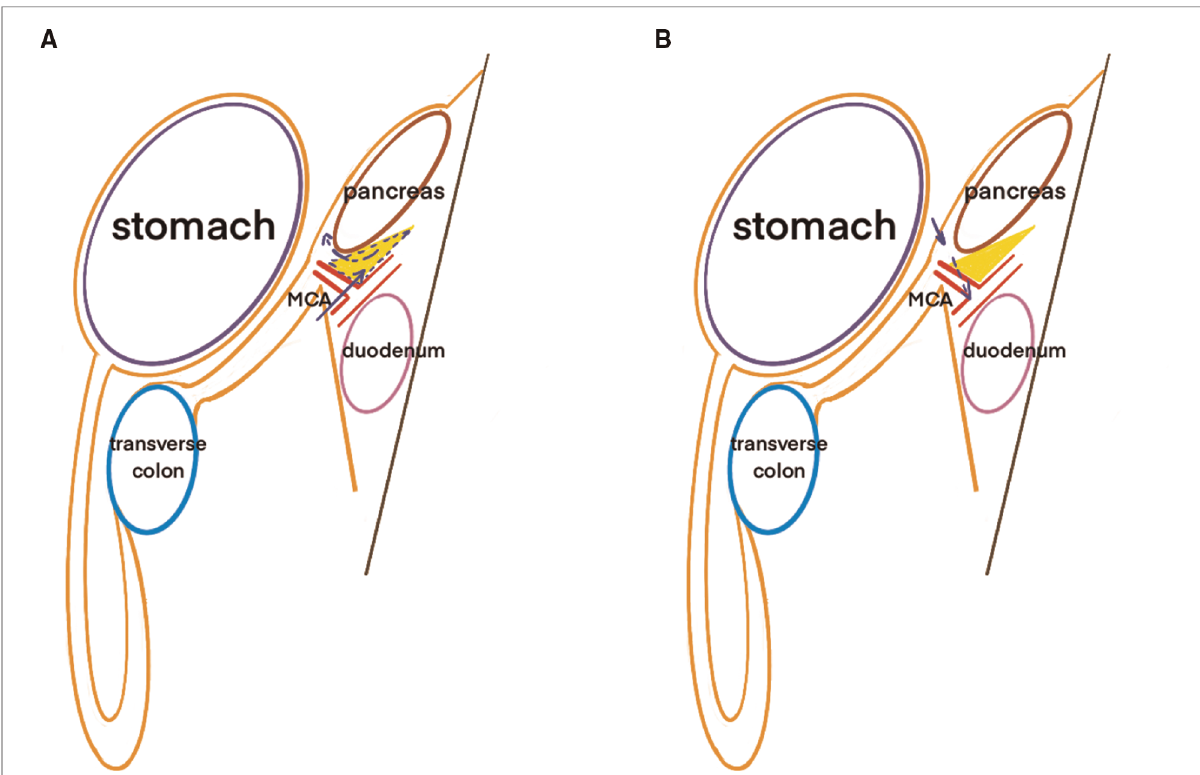
FIGURE 1 Schematic diagram of the different approaches in transverse colectomy. Note: ( A ) was referred to the caudal-to-cephalic approach and ( B ) was referred to the caphalic-to-caudal approach. The yellow triangle was referred to the lymph nodes concealed beneath and behind the lower border of pancreas which could be missed in cephalic-to-caudal approach. The arrow was referred to the different surgical